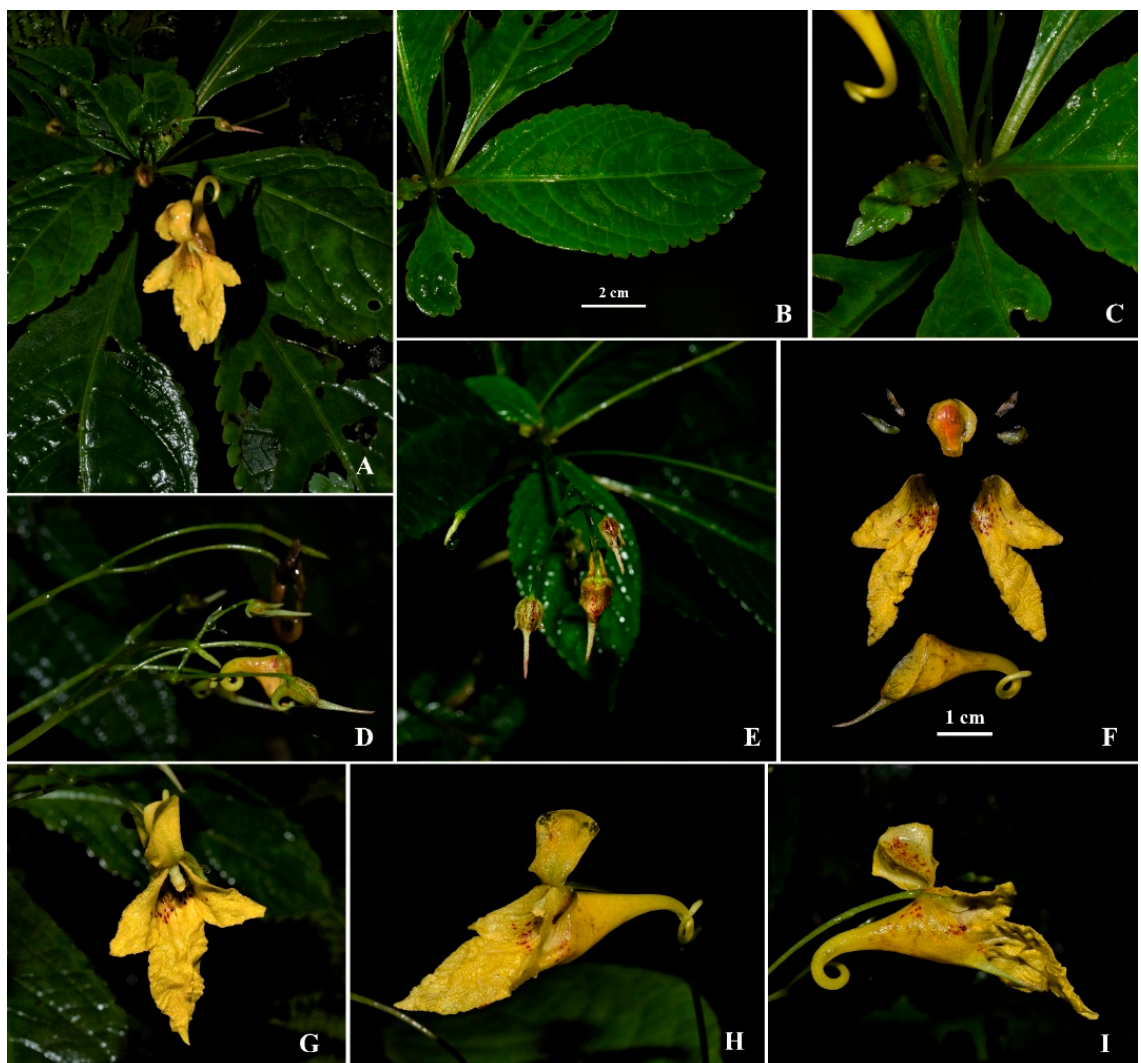
Figure 1. Impatiens longiaristata S. Peng, G. W. Hu & Q. F. Wang. ( A ) Habit, ( B ) Leaf, ( C ) Petiole, ( D ) Flower buds, ( E ) Inflorescence, ( F ) Flower anatomy, ( G ) Front view of flowers, ( H , I ) Lateral views of flowers (photographed by Shuai Peng).